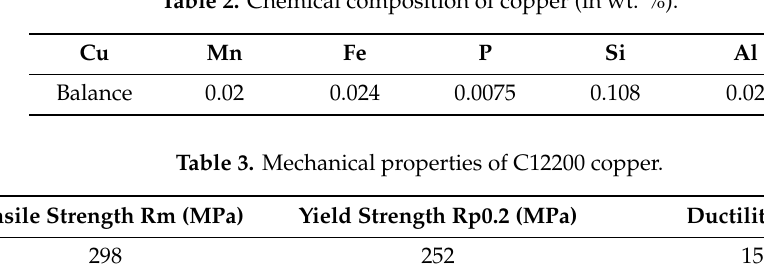
Table 2. Chemical composition of copper (in wt. %).